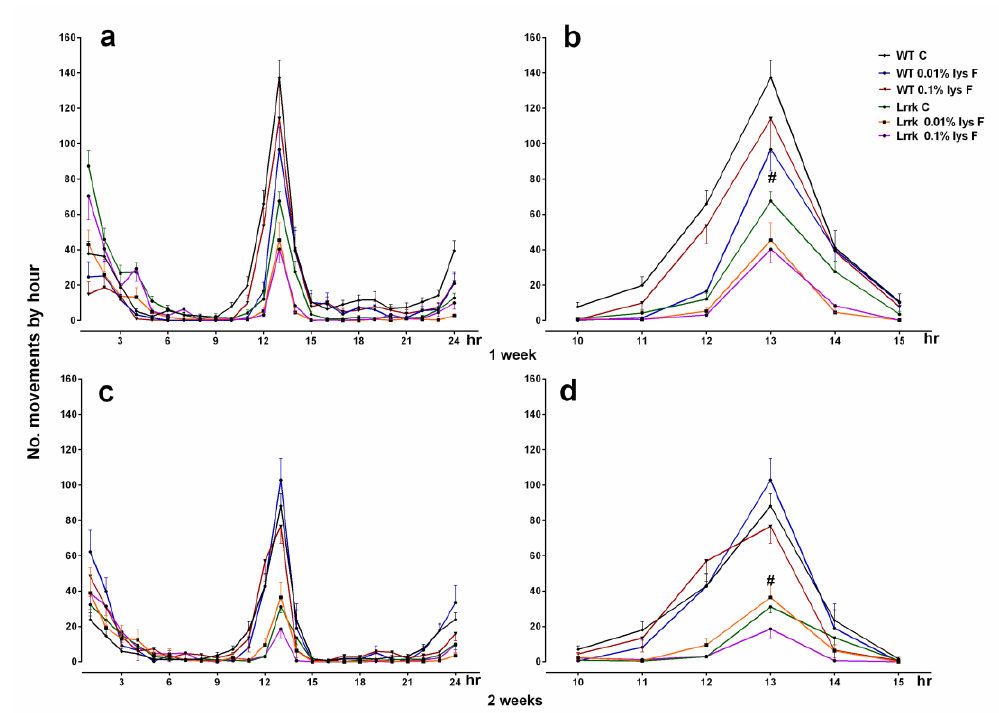
Figure 3. Illustrates the 5 hr and 24 hr time – course in WT and LRRK mutant flies treated with fDLE (Figure 1b) after 7 and 14 days of treatment. # = p < 0.001 LRRK strain versus WTs and ** = p < 0.001 LRKK C versus LRRK fDLE-treated (0.01%, Tukey ’s